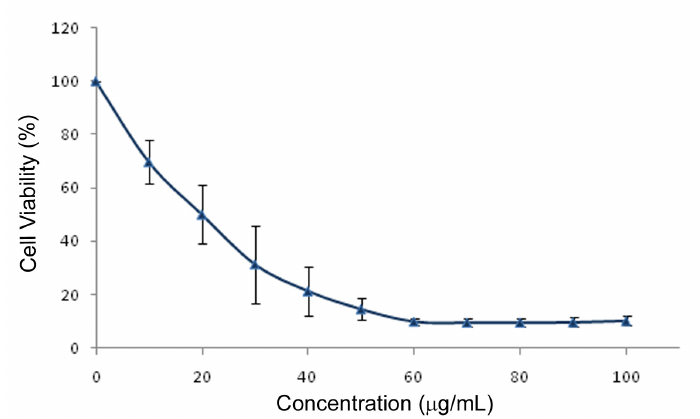
Figure 3 . MTT-Dose-response relationship of a ginseng ( Panax ginseng ) extract after 72 h incubation with 3T3-L1 cells assessed by an MTT viability assay. Values are expressed as percentage of untreated control cells (mean ± SD).